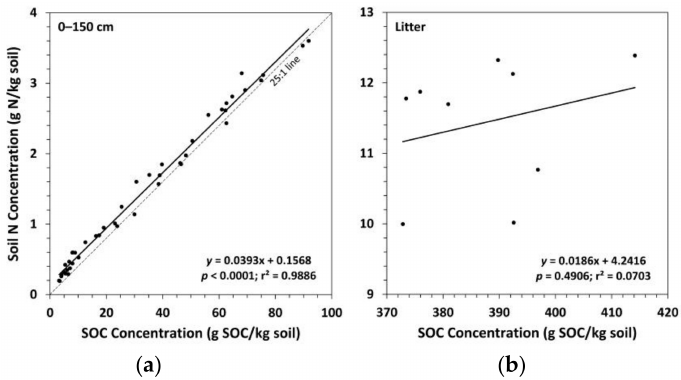
Figure 5. Soil nitrogen (N) concentration versus soil organic carbon (SOC) concentration for: ( a ) the whole mineral soil ( n = 45); ( b ) the litter layer ( n = 9). Dashed 25:1 line added to provide a reference for the C:N ratio for the whole mineral